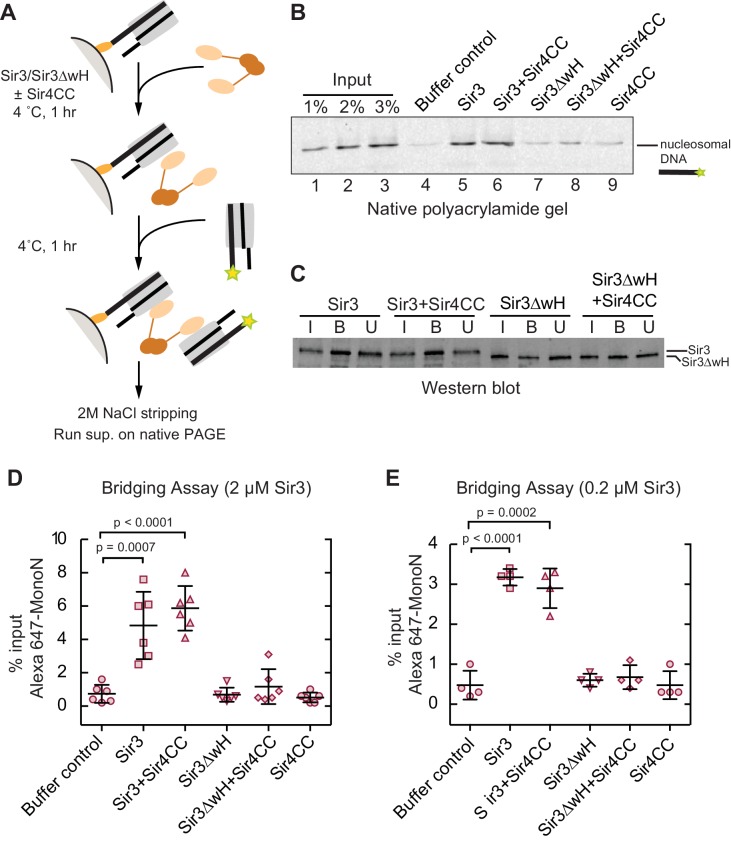
Sir3 crosslinks free mono-nucleosomes in solution.(A) Illustration of the crosslinking assay. (B) A representative native polyacrylamide gel showing the fluorescent DNA pulled down from different reaction mixtures. (C) A representative western blot showing Sir3 and Sir3ΔwH in all reactions bound to nucleosomes efficiently. I, input; B, bound, U, unbound. (D) Percentage of input Alexa 647- nucleosomes that was pulled down in different reaction mixtures where 2 µM Sir3 or Sir3ΔwH protein concentration was used. Quantification for 6 experiments is presented. (E) Same as D but using 0.2 µM Sir3 or Sir3ΔwH protein. Quantification for 4 experiments is presented.